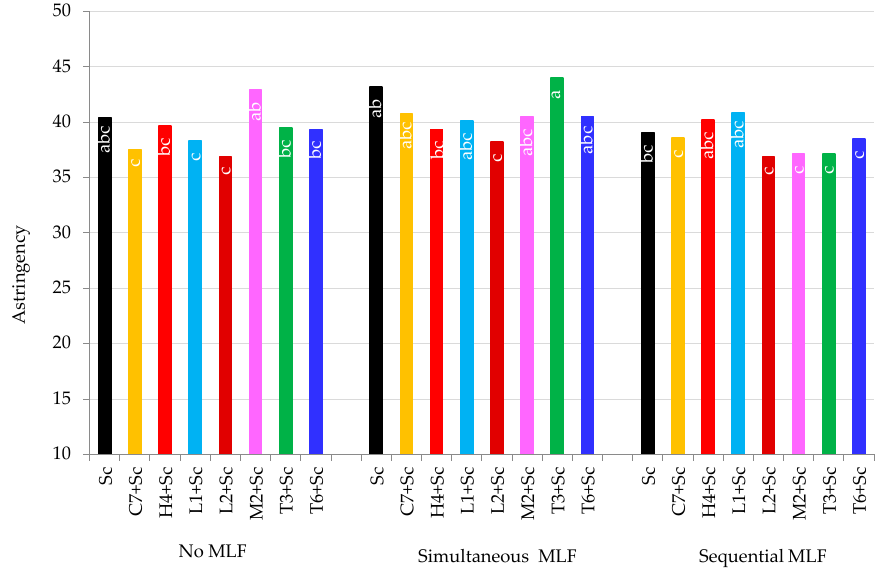
Figure 6. Percentage (%) astringency of Shiraz wines produced with Saccharomyces cerevisiae (Sc) on its own or in combination with Candida zemplinina C7, Hanseniaspora uvarum H4, Lachancea thermotolerans strains L1 and L2, Metschnikowia pulcherrima M2 and Torulaspora delbrueckii strains T3 and T6, as well as three malolactic fermentation (MLF) strategies (none, simultaneous and sequential). Mean values followed by the same letter did not differ significantly ( p ≤ 0.5).